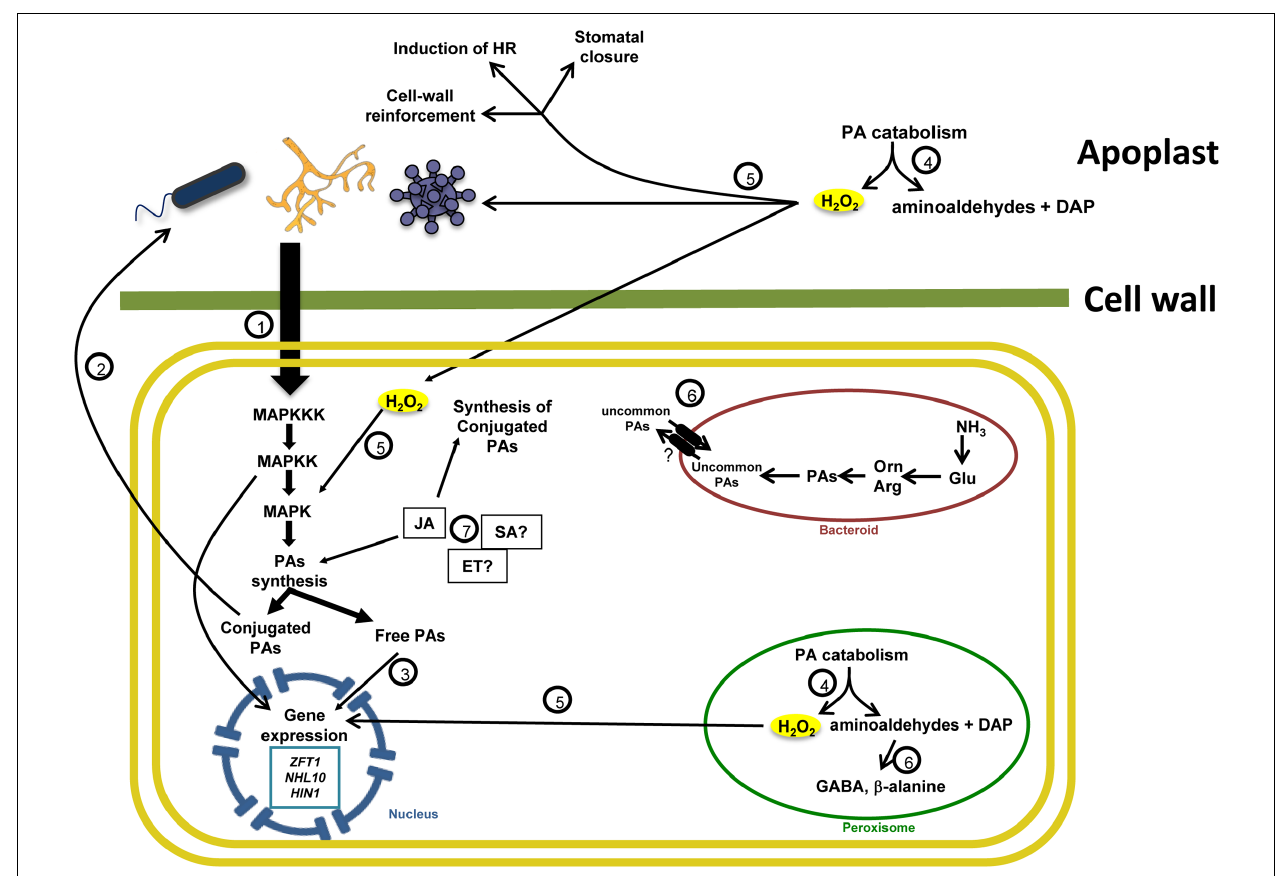
FIGURE 1 | Polyamine metabolism in plant-microorganism interactions. (1)The presence of microorganisms is perceived by specific plant receptors that activate signal transduction pathways. Many MAP kinases, such asWIPK and SIPK, participate in these pathways stimulating defense gene expression and PA biosynthesis.This process leads to the accumulation of free and conjugated PAs. (2) Some conjugated PAs have an antimicrobial effect. (3) In turn, free PAs might contribute to the activation of gene expression directly or through their catabolism. (4) PA oxidation by DAO and PAO occurs in the peroxisome and apoplast, with the generation of H 2 O 2 , DAP and aminoaldehydes. (5) H 2 O 2 acts as signaling molecule and stimulates defense